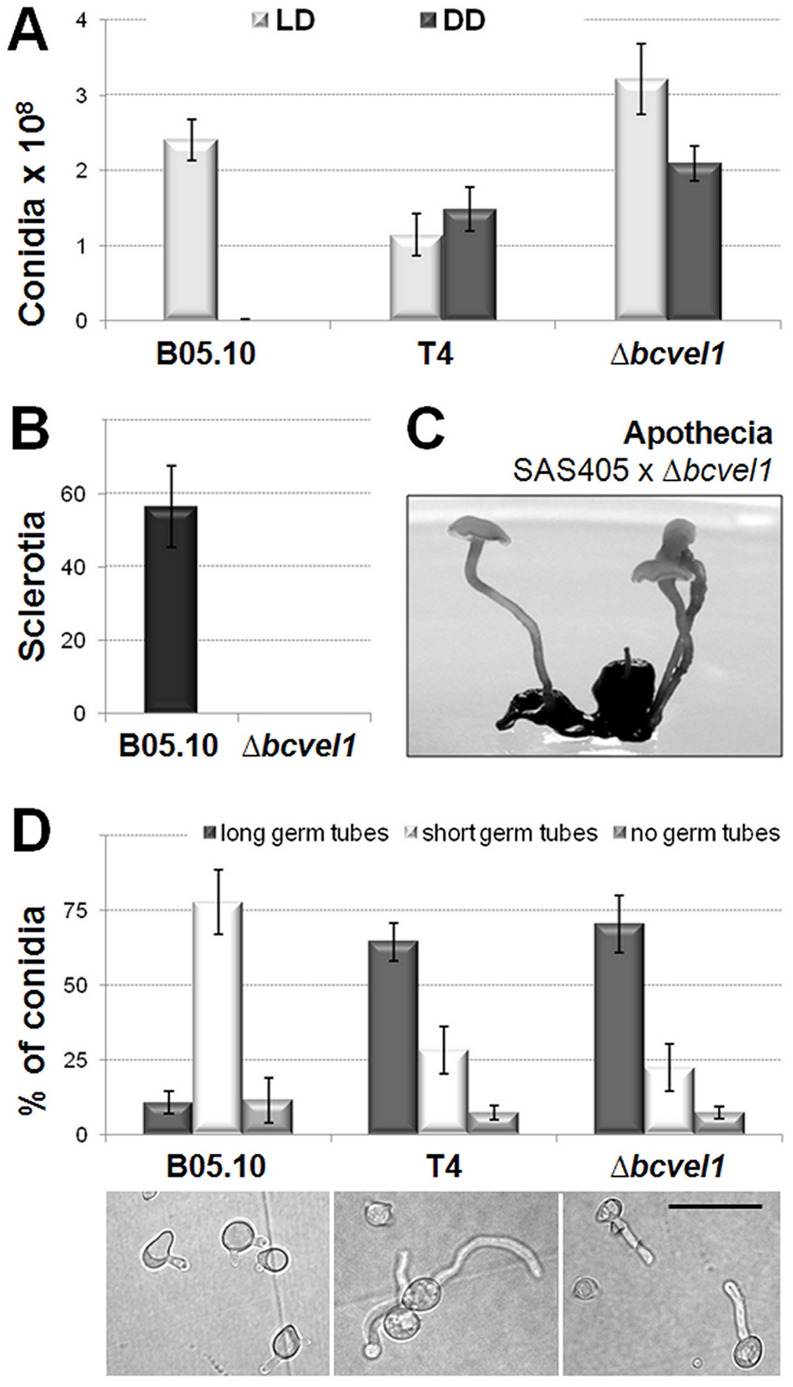
Impact of BcVEL1 on asexual and sexual reproduction and conidial germination.(A) Numbers of conidia (per Petri dish) produced by the strains in light-dark (LD) conditions and in continuous darkness (DD), respectively. Data represent mean values of the results from three Petri dishes per strain and condition. (B) Numbers of sclerotia (per Petri dish) produced by the strains in continuous darkness. Data represent mean values of the results from three Petri dishes per strain and condition. (C) Apothecia derived from crossing of sclerotia of strain SAS405 (MAT1-2) with microconidia of mutant B05.10:Δbcvel1 (MAT1-1). Picture was taken after 14 weeks of joining sclerotia and microconidia. (D) Germination on hydrophobic surfaces. Conidia were suspended in water and incubated for 24 h on polypropylene. The experiments were done in triplicates, each time hundred conidia were counted. Short germ tubes do not exceed the length of the conidia while long germ tubes do. Scale bar represents 20 µm.